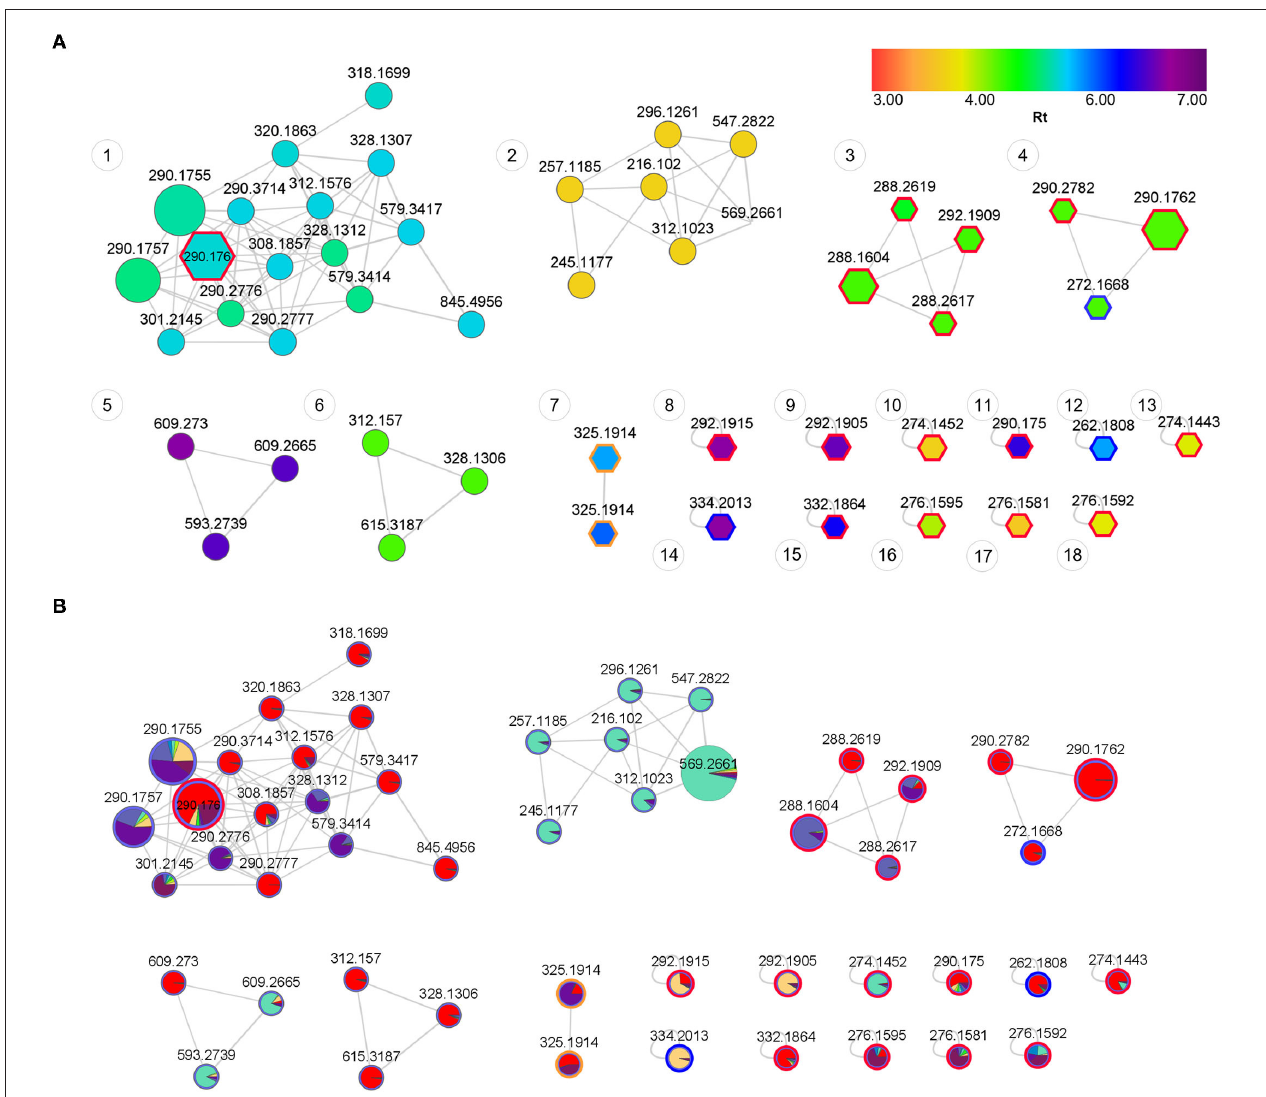
FIGURE 6 | (A) Feature-based molecular network of Sceletium populations showing structural trends. Annotated nodes with pentagon boarders represent putatively identified metabolites ( Table 2 ). Red outlines represent the mesembrine alkaloids, blue outlines represent joubertiamine alkaloids and orange outlines represent Sceletium A4 alkaloid class. Nodes are colored by retention time (RT) with their size representing the abundance of the metabolite. The distance between nodes indicates structural similarity based on fragmentation patterns from tandem mass spectrometry data. (B) Feature-based molecular network of Sceletium populations showing phytochemical distribution trends across populations. Red: S. tortuosum (De Rust); Blue: S. strictum (Anysberg); Green: S. expansum (Calitzdorp) and Purple: S. rigidum (Prince